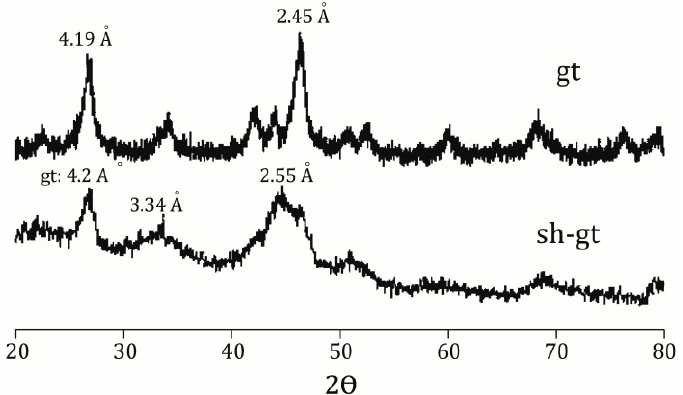
Figure 2. X-ray diffraction pattern for goethite (gt) and schwertmannite (sh-gt) with adsorbed